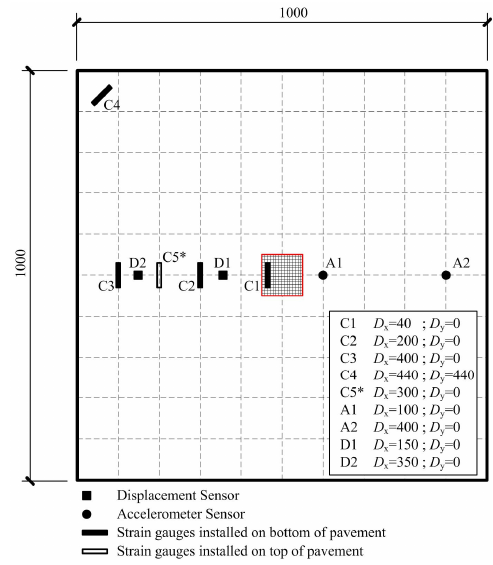
Figure 4. Casting of RCP specimen.